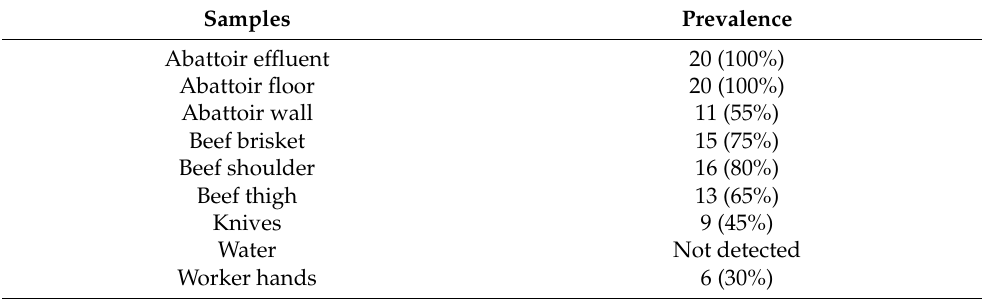
Table 1. Prevalence of E. coli in different kinds of samples taken from beef carcasses and slaughter- house environments ( n =